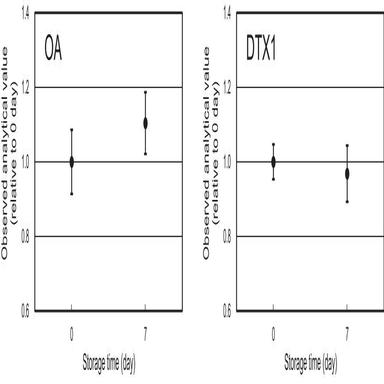
Comparison of observed analytical values (relative) of OA and DTX1 determined before and after the short-term stability assessment of CRM 7520-a. The assessment was performed at approximately 2 °C over 7 days. Each bar shows combined standard uncertainty obtained as in the case of